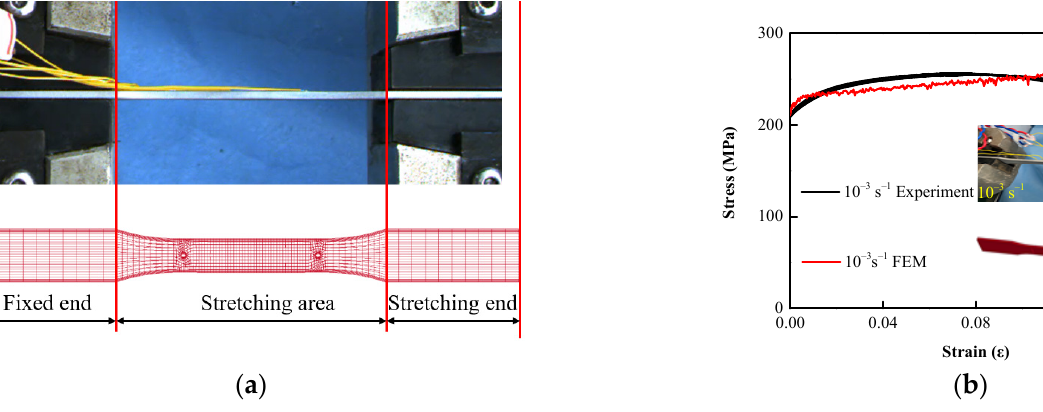
Figure 5. FEM: ( a ) boundary setting of the FEM; ( b ) comparison of the results. Table 2. Properties of Si ‐ Al alloy AlSi10Mg.